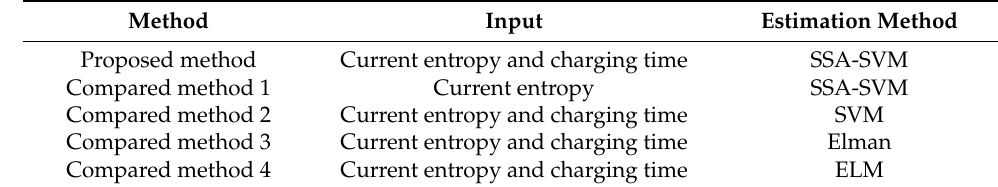
Table 2. The specifics of the comparative experiment.